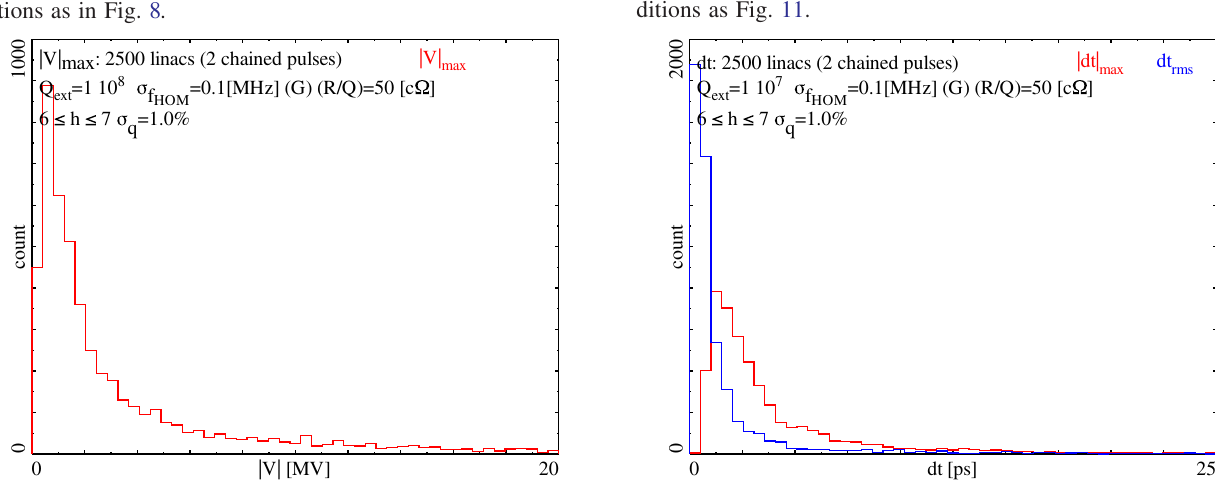
FIG. 24. (Color) Histogram of dt [0–25 ps, 50 bins], Q ext ¼ 10 7 worst: red; rms: blue; 2500 different HOM setups; conditions as in Fig.